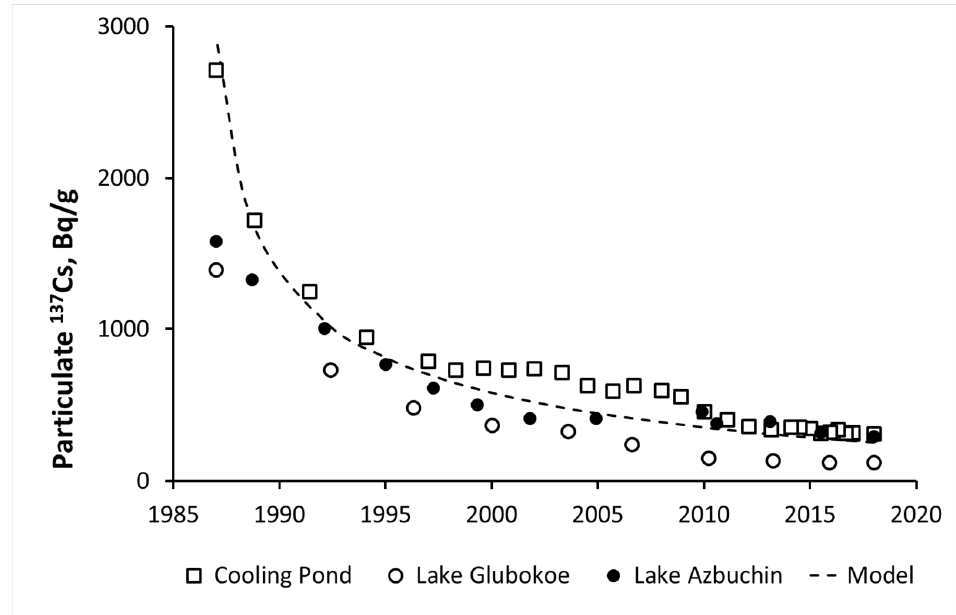
Figure 4. Time dependence of particulate 137 Cs activity concentrations in Lakes Glubokoe, Lake Azbuchin, and Cooling Pond after the accident in 1986, back calculated from the 137 Cs depth distribu- tion in the bottom sediments collected in 2018 in deep-water zones. Dashed line—calculation by the semiempirical diffusional model (Equation (2)) at c 0 p = 3000 Bq · (y) 1/2 g − 1